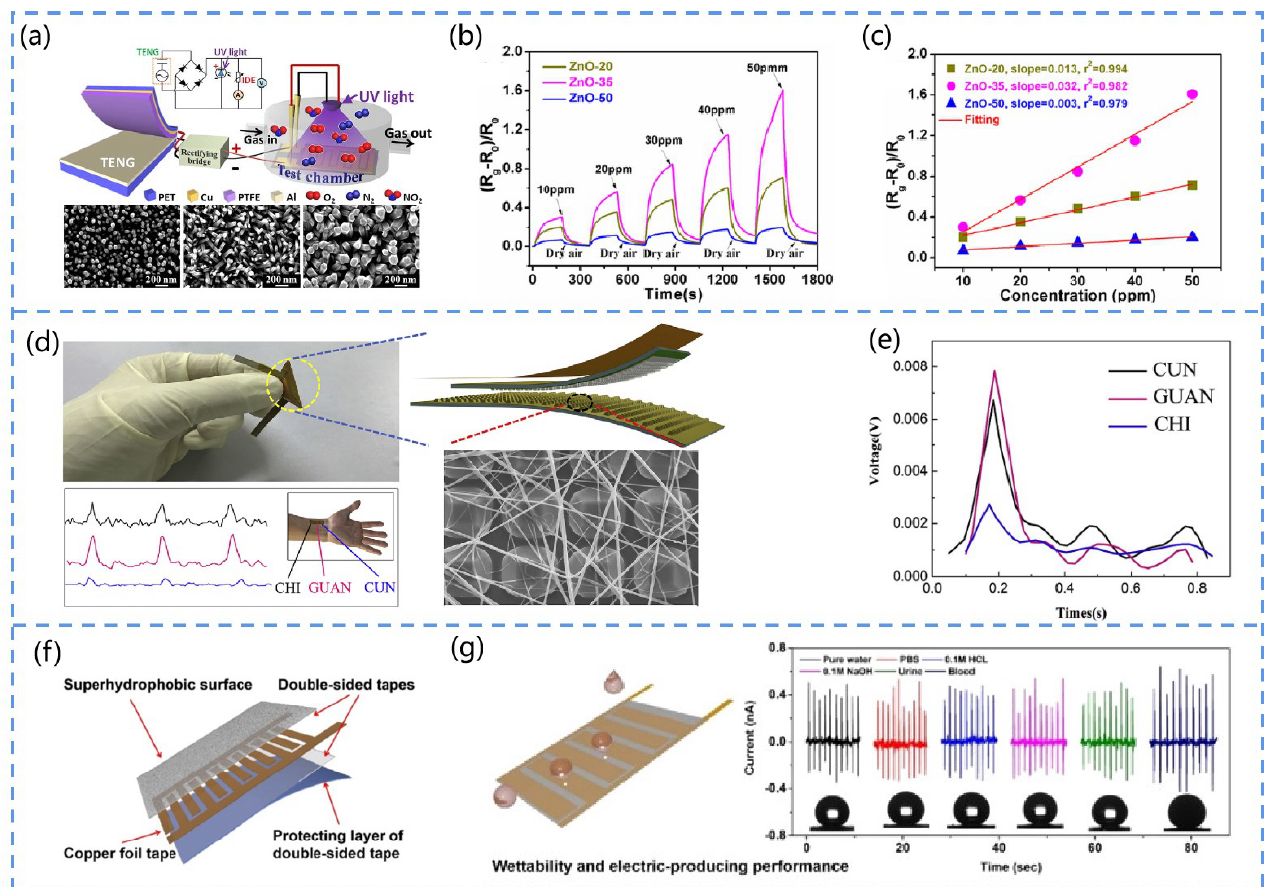
Figure 11. ( a ) Schematic diagram of the TENG-based sensing system for active NO 2 detection. ( b ) Schematic diagram of the response of ZnO nanowire films from 0 to 100 ppm NO 2 . ( c ) Plot of ZnO nanowire film versus NO 2 concentration. Reprinted from [85] with permission from AIP Publishing. ( d ) Schematic diagram of the principle and structure of the sensing system. ( e ) Comparative analysis of real-time voltage signals at different locations on the hand: the CUN, GUAN, and CHI. Reprinted from [86] with permission from Elsevier. ( f ) Schematic diagram of the superhydrophobic TENG structure. ( g ) Current output generated by different liquids sliding on the superhydrophobic TENG. Reprinted from [87] with permission from ACS Publications.